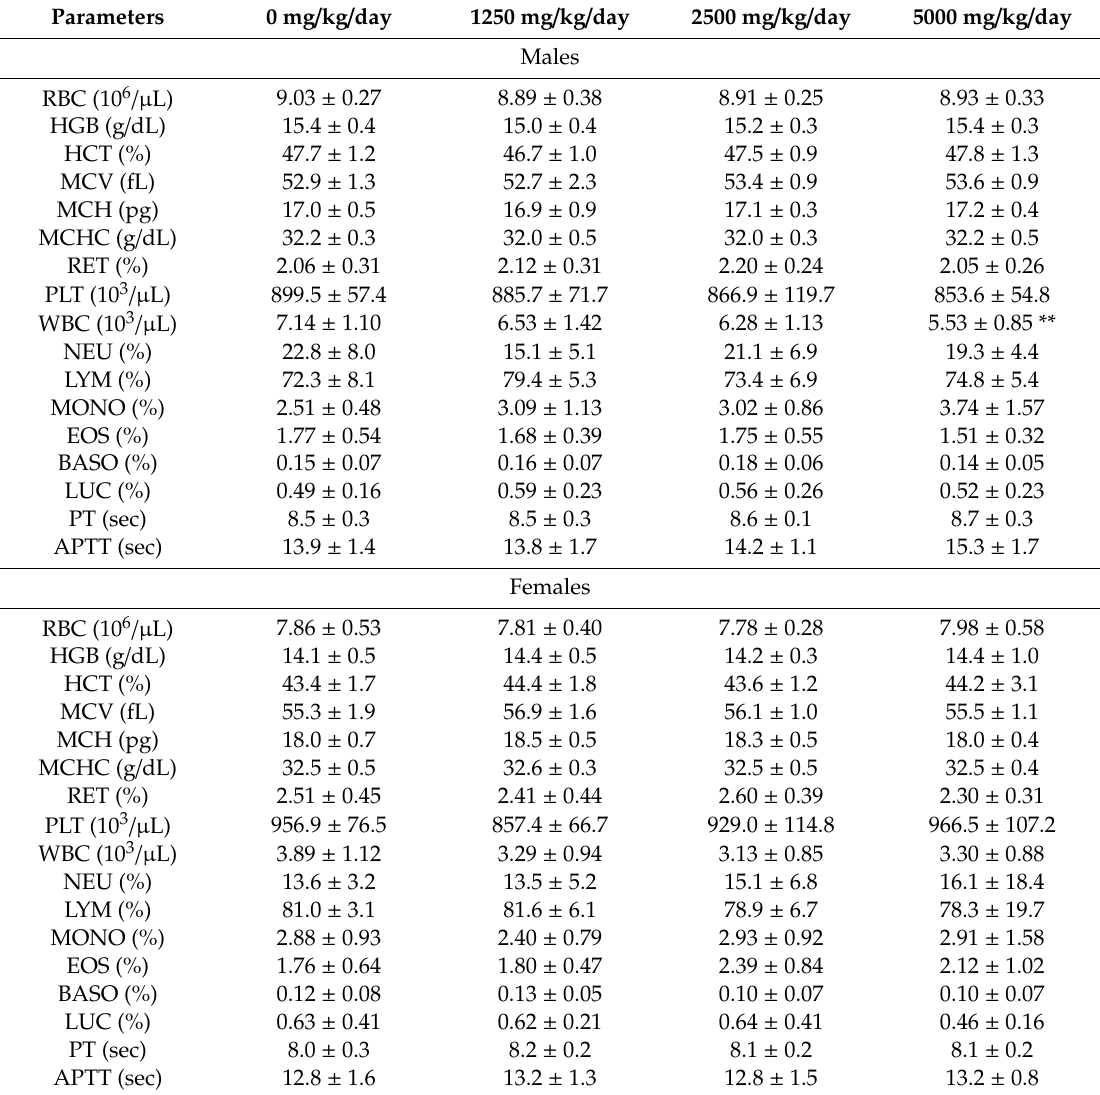
Table 3. Hematological data of SD rats orally administered frpfdZAL for 13 weeks.